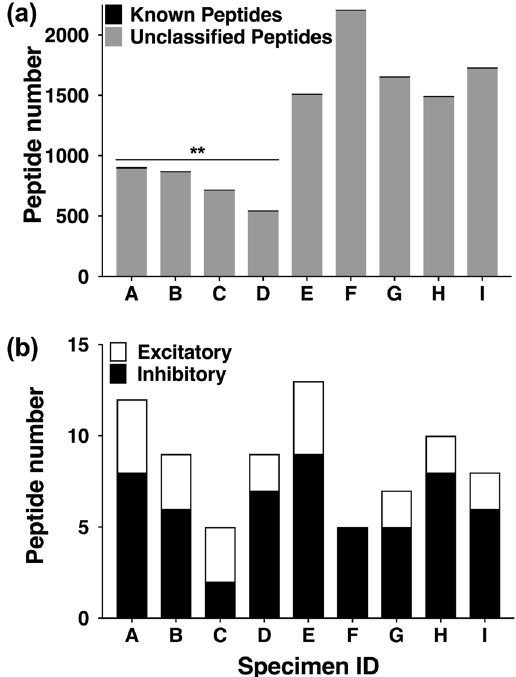
Figure 1. The number of masses detected in the injected predatory venom of C. purpurascens . ( a ) The number of known and unknown masses in the injected predatory venom of each specimen. ( b ) The contribution of known excitotoxins and neuromuscular blockers to the venom of each specimen. Two μ L of the venom from each specimen was analysed with Sciex TripleTOF 5600 instrument. The masses were identified using the Analyst ™ 1.6 program (Sciex) and were pre- processed to detect and remove duplicates, Na + and K + adducts using mass processing tools of ConoServer. The resulting number of unique masses from each specimen is graphically represented. A significant difference (P < 0.01) in the peptide number between specimens A to D and E to I was found with unpaired t-test.